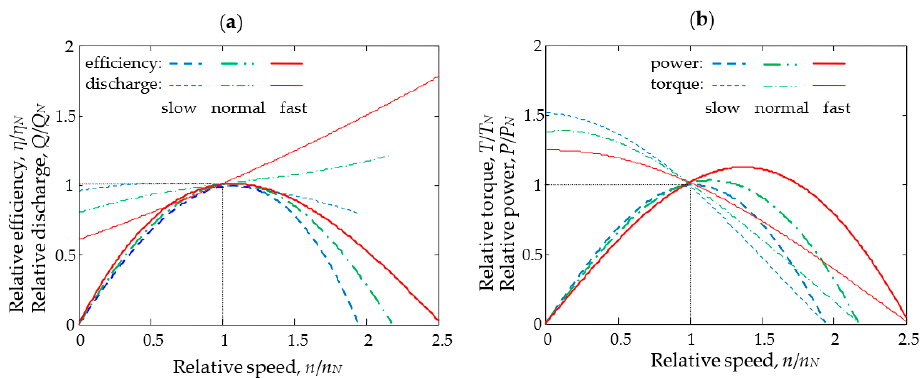
Figure 2. Comparison of non-regulated turbine (slow, normal and fast) features using relative ffi ciency and discharge and ( b ) power and variable curves. ( a ) Efficiency and discharge and ( b ) power and torque curves. ( a ) E